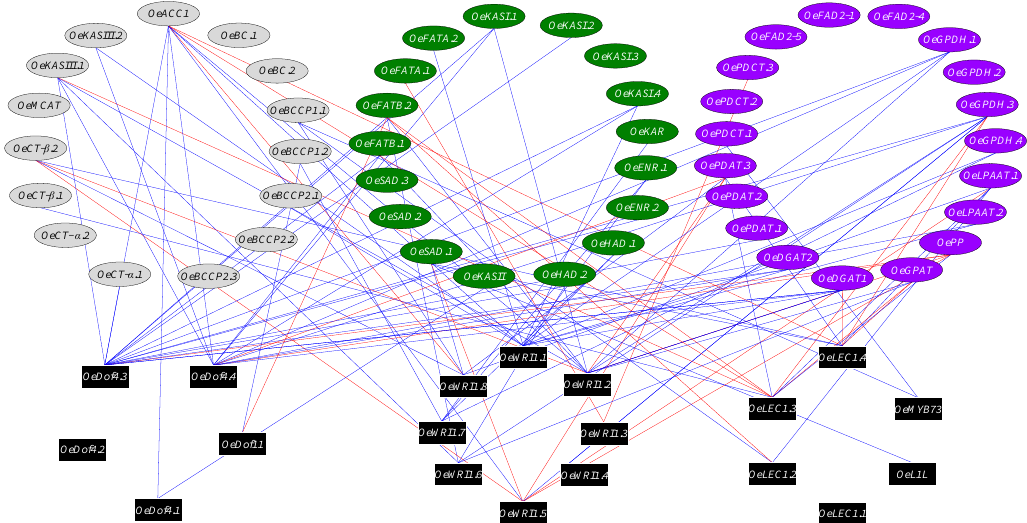
Figure 4. TF-oil biosynthesis network. Co-expressed network of the correlation among Transcription factors (colored in black) and Oil biosynthesis genes. The blue and red lines indicate positive and negative correlations between two genes, respectively. The oil biosynthesis genes are colored in green, gray and purple for plastid, cytosol and ER,